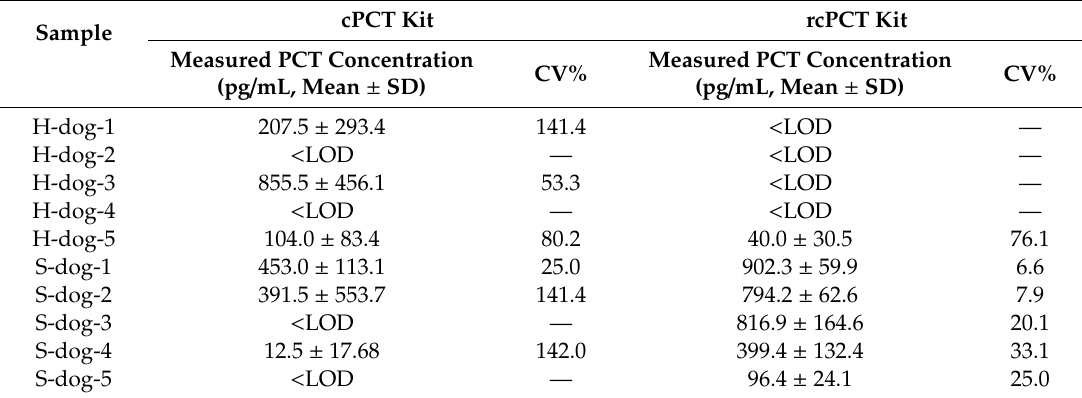
Table 5. PCT concentrations in healthy and sick dogs measured with the cPCT and rcPCT ELISA kits. CV—coe ffi cient of variation; LOD—limit of